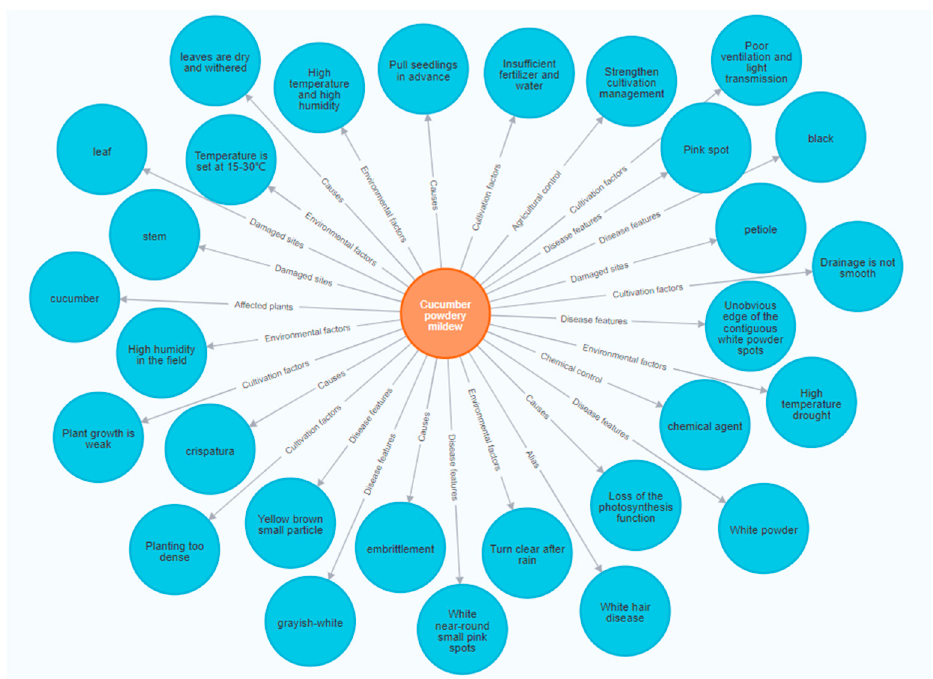
Figure 8. Crop disease domain knowledge graph.